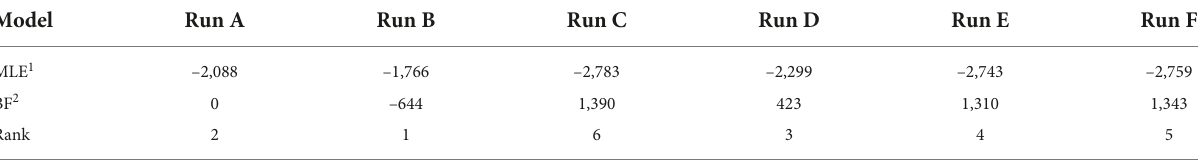
TABLE 2 SNAPPER results for different species delimitation